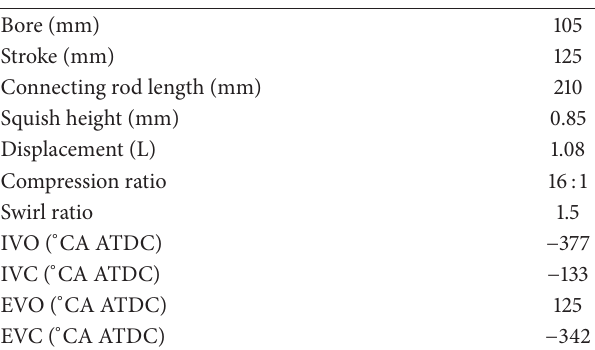
Table 1: Engine and injector